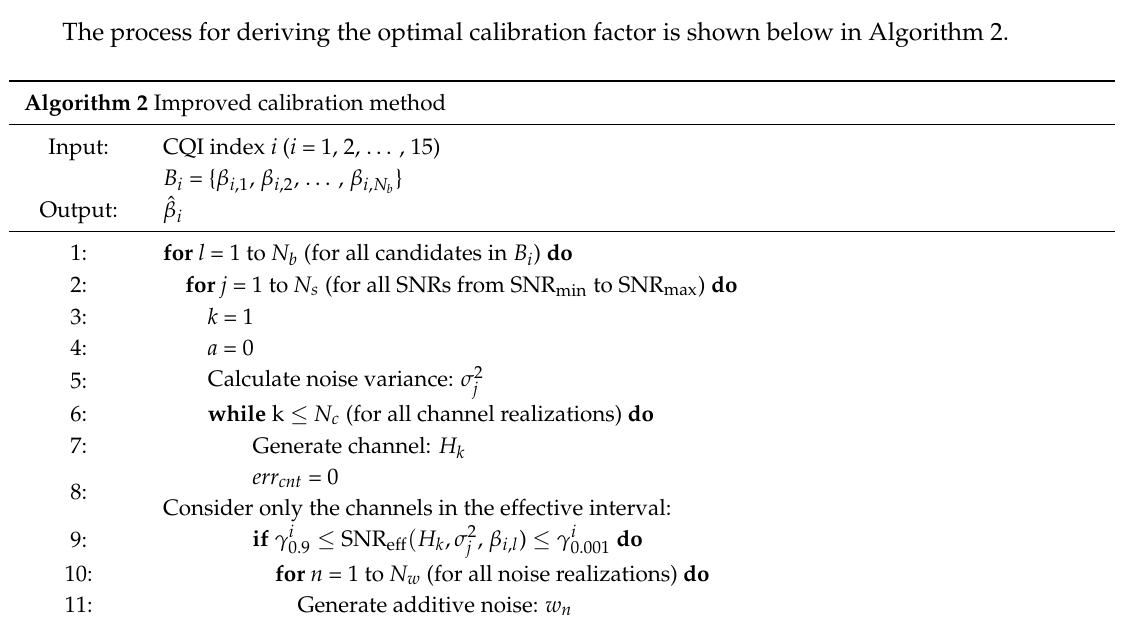
Figure 1. Selecting the additive white Gaussian noise (AWGN) signal-to-noise ratio (SNR) range from the probability density function (p.d.f) for the improved calibration procedure.